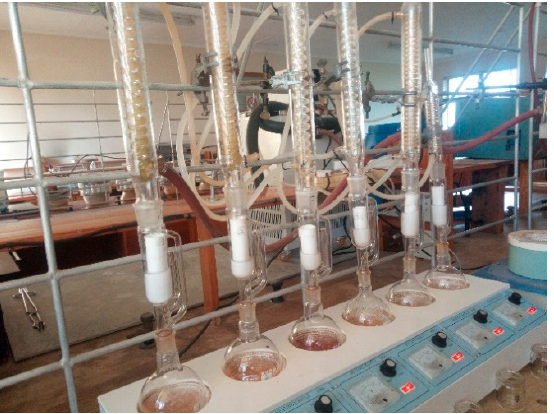
Figure 5. Soxhlet extraction setup for biomass compositional analysis.